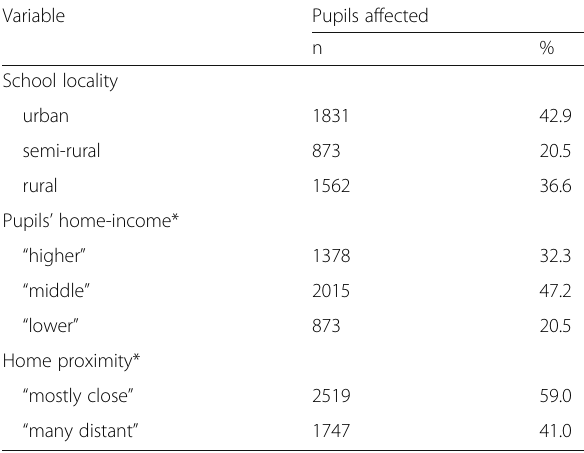
Table 1 School variables (from teachers ’ questionnaires), and numbers of participant pupils affected ( N = 4266)